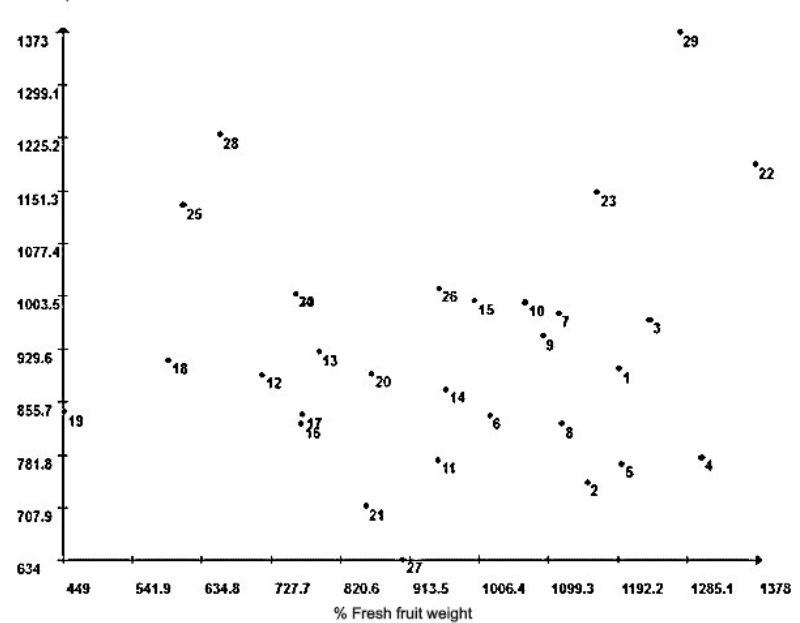
Figure 3. Scatter plot of 30 buriti ( M. flexuosa ) individuals based on the two traits that showed the greatest relative dissimilarity (S.j′) contribution, analyzed according to Singh [10] criteria.